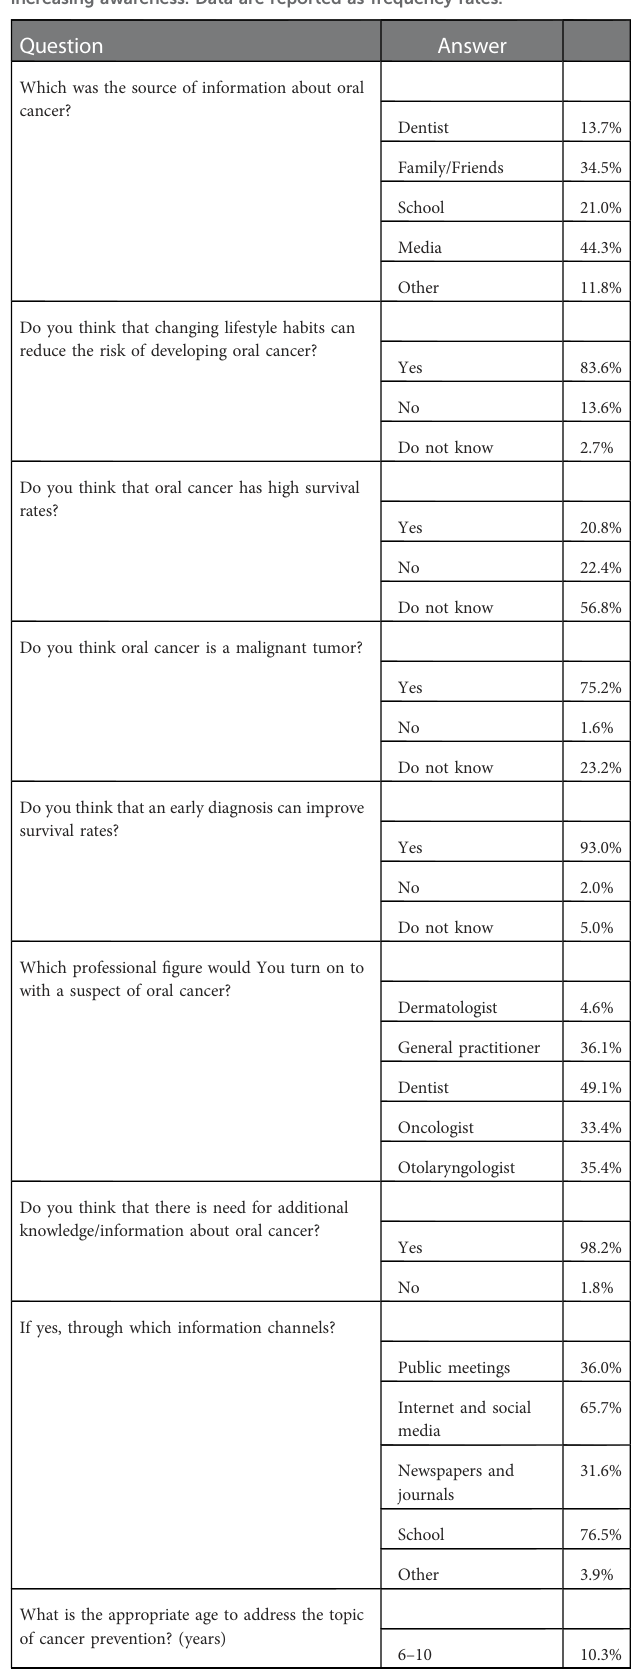
TABLE 1 Demographic characteristics of the participants and categorization in subgroups. Data are reported as frequency rates or mean±standard deviation (for age).